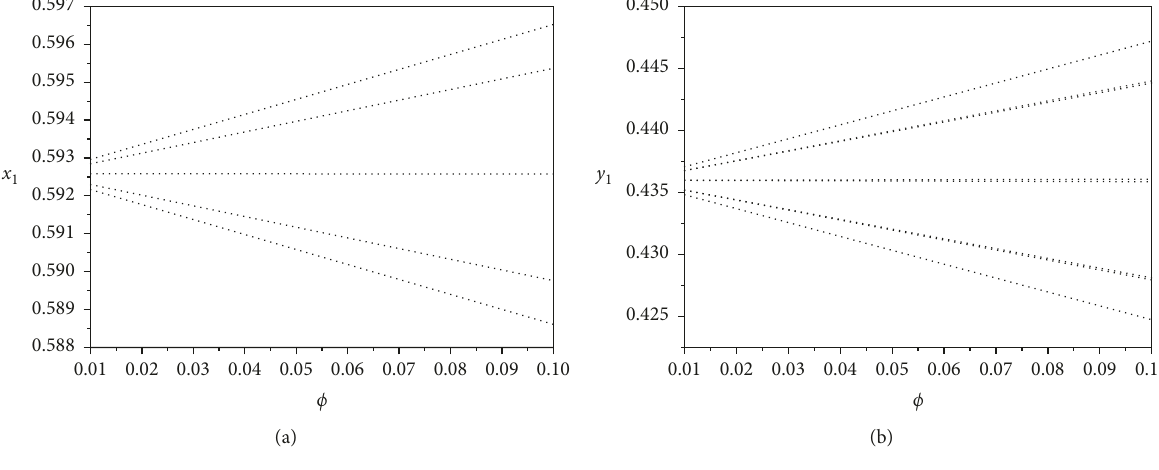
Figure 18: Dynamic bifurcation diagram: (a) x 1 ; (b) y 1 Due to the basement excitation, the external force of indicates that the unbalance force and nonlinear oil force of equations is affected, as a result the rotor orbit has the system play a dominant role during the whole process of changed and clearly shows several single-closed curves. operation.